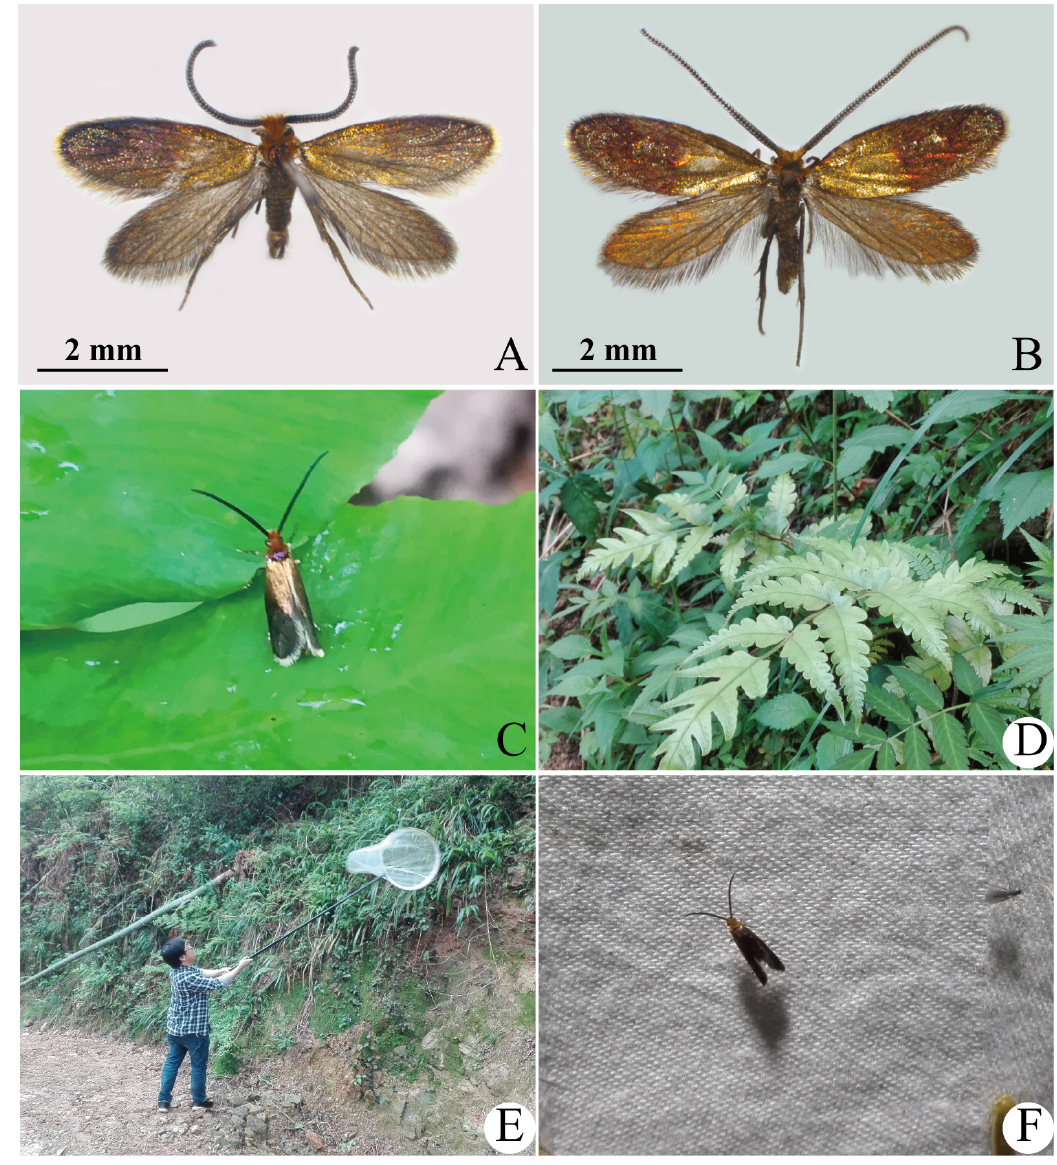
Fig. 1. Adults and habitat of Vietomartyria spp. A . Vietomartyria wuyunjiena sp. nov., holotype, ♂. B . Vietomartyria maoershana sp. nov., holotype, ♂. C . One adult of V. wuyunjiena sp. nov. perching